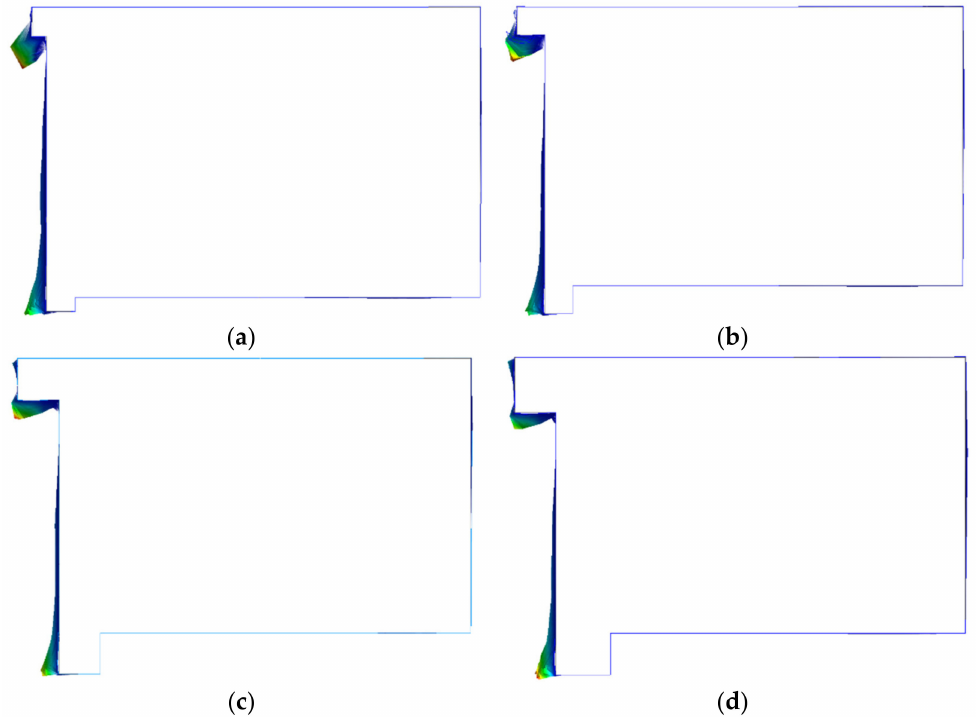
Figure 17. Side view of ice distribution on cross beam with different dimension of module. ( a ) The model width is 0.02 m and the thickness is 0.01 m. ( b ) The model width is 0.02 m and the thickness is 0.02 m. ( c ) The model width is 0.03 m and the thickness is 0.03 m. ( d ) The model width is 0.04 m and the thickness is 0.03